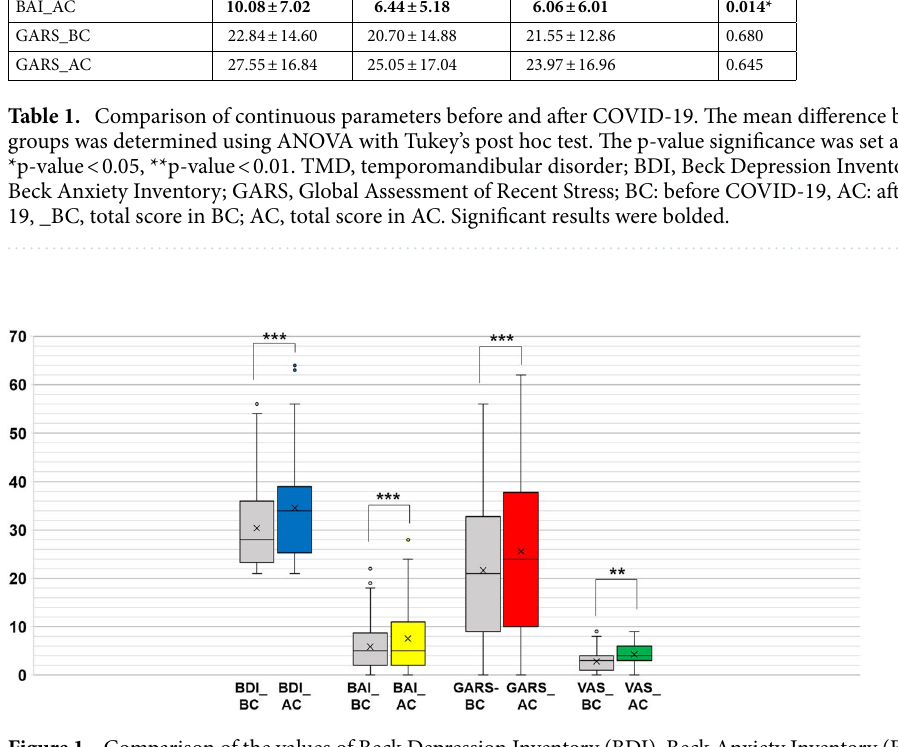
Figure 1. Comparison of the values of Beck Depression Inventory (BDI), Beck Anxiety Inventory (BAI), Global Assessment of Recent Stress (GARS), and Visual Analog Scale (VAS) before and after COVID-19. Results were obtained using a paired t-test. Statistical significance was set at p-value < 0.05. **p-value < 0.01, ***p-value < 0.001. TMD, temporomandibular disorder; MOL, mouth opening limitation; BDI, Beck Depression Inventory; BAI, Beck Anxiety Inventory; GARS, Global Assessment of Recent Stress; VAS, visual analog scale; BC: before COVID-19, AC: after COVID-19, -BC, total score in BC; -AC, total score in